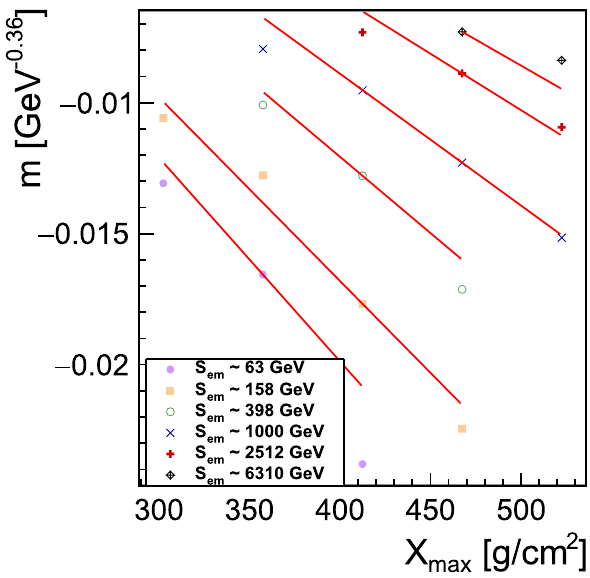
Fig. 11 Correlation of the variable f 20 , as defined in the text, with the calibration coefficient C , for events with S em ∼ 200GeV and X max ∼ 350g / cm 2 (see text for the simulation details)